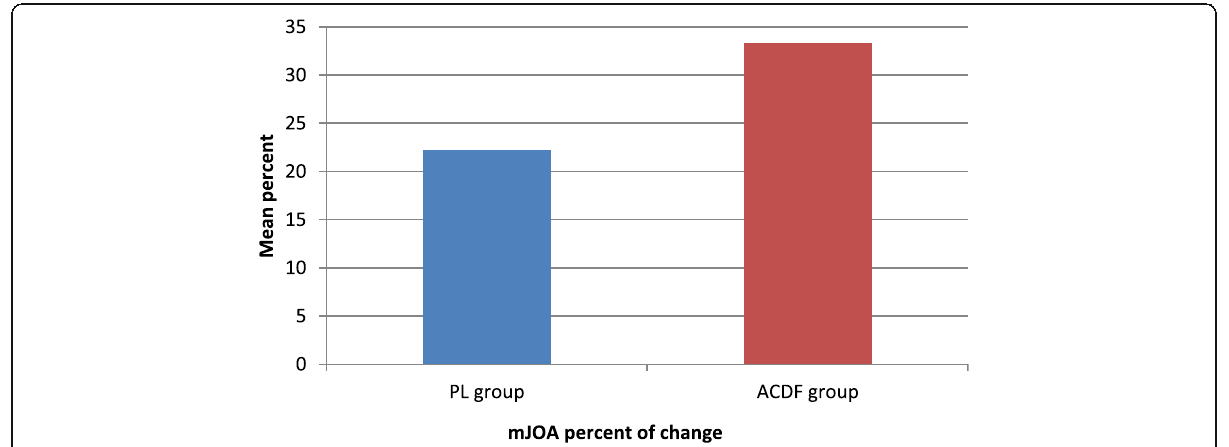
Fig. 3 mJOA score percent of change in mean values following surgery in both